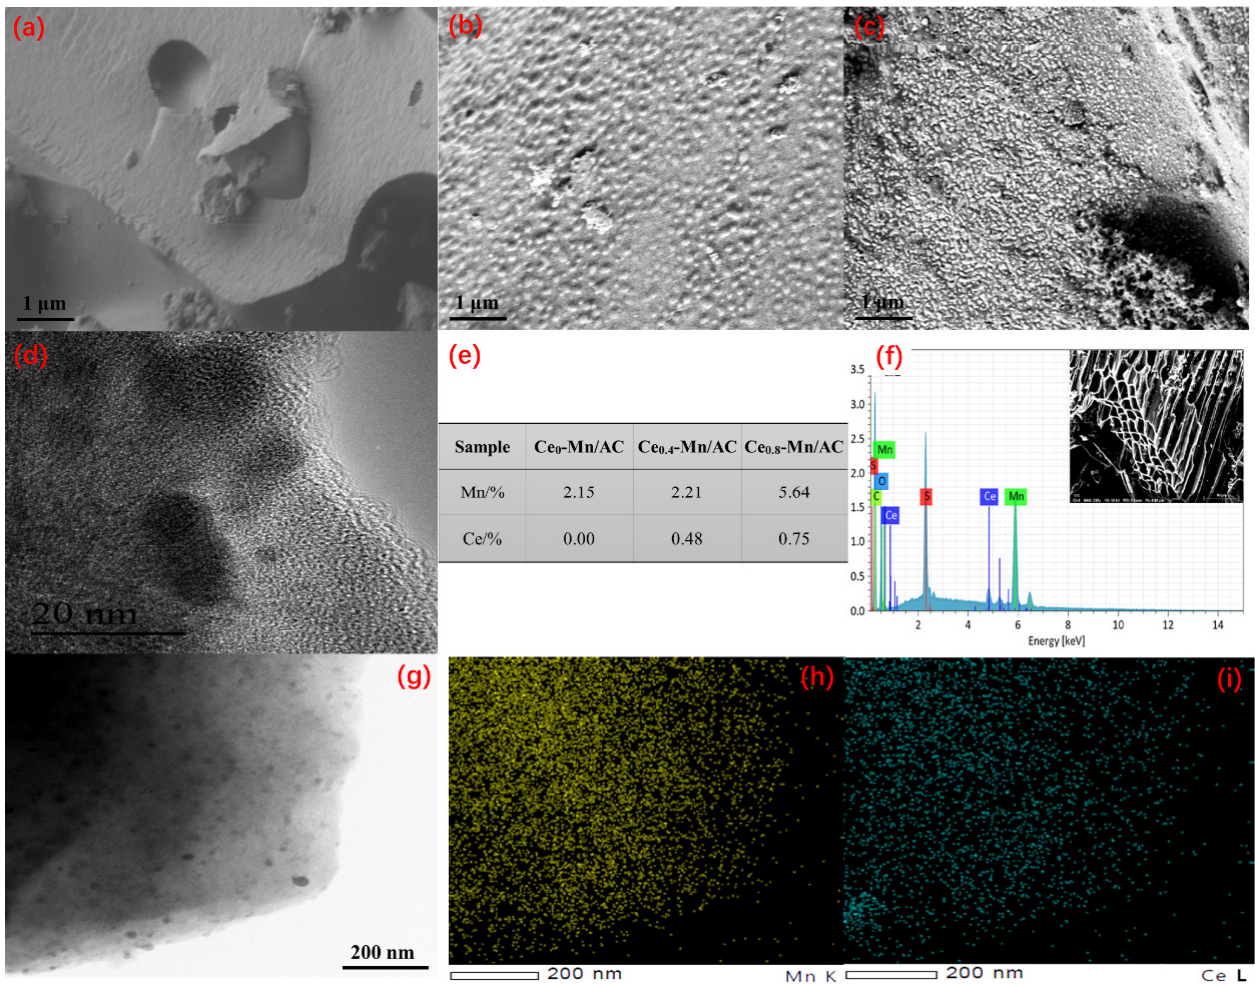
Figure 5. Scanning electron microscope (SEM) images of AC ( a ); Ce 0.4 -Mn/AC ( b ); Ce 0.8 -Mn/AC ( c ); transmission electron microscope (TEM) images of Ce 0.8 -Mn/AC ( d , g ); elemental contents of different catalysts ( e ); EDS spectra of Ce 0.8 -Mn/AC ( f ); EDS elemental mapping of Mn ( h ) and Ce ( i ) on the Ce 0.8 -Mn/AC.